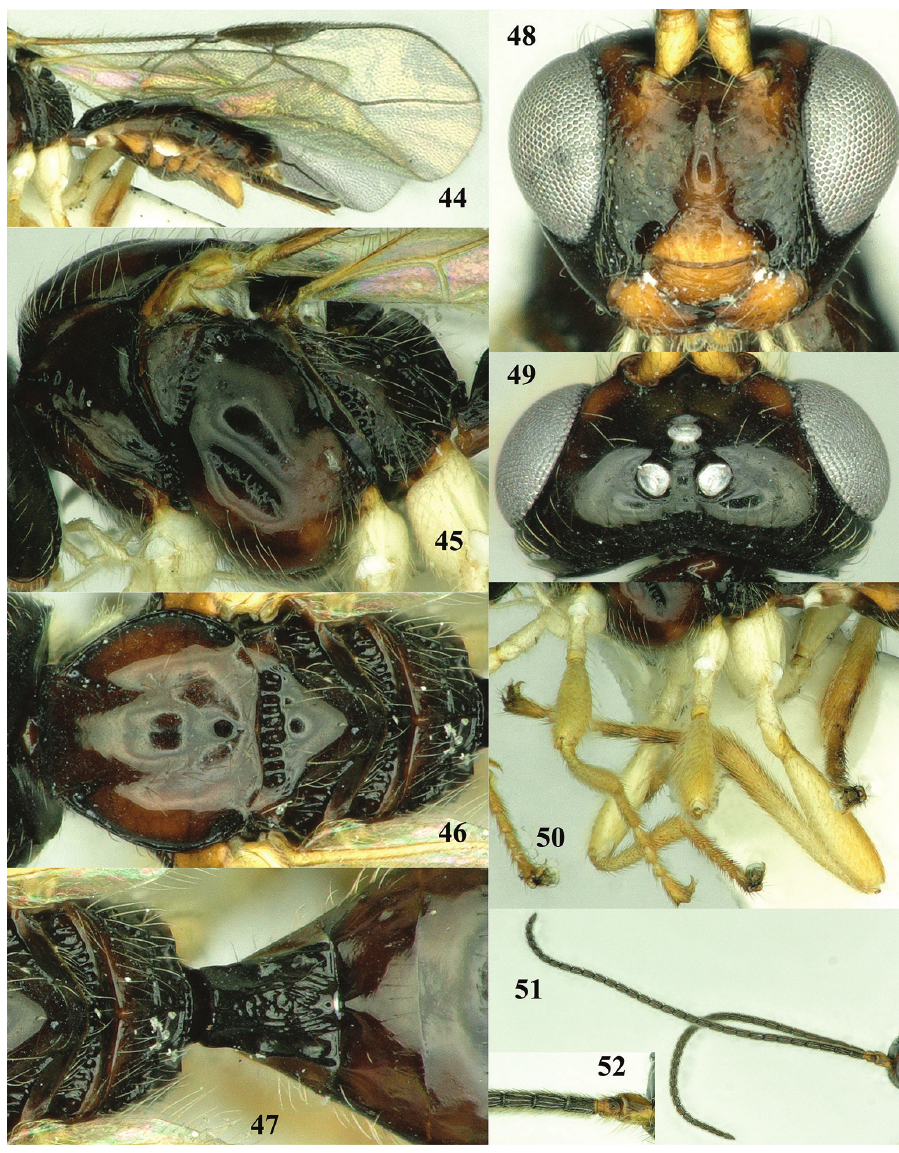
Figures 44–52. Rhogadopsis moniliata sp. n., female, holotype. 44 wings 45 mesosoma lateral 46 meso- soma dorsal 47 propodeum and first-third metasomal tergites dorsal 48 head anterior 49 head dorsal 50 hind leg 10 head lateral 52 base of